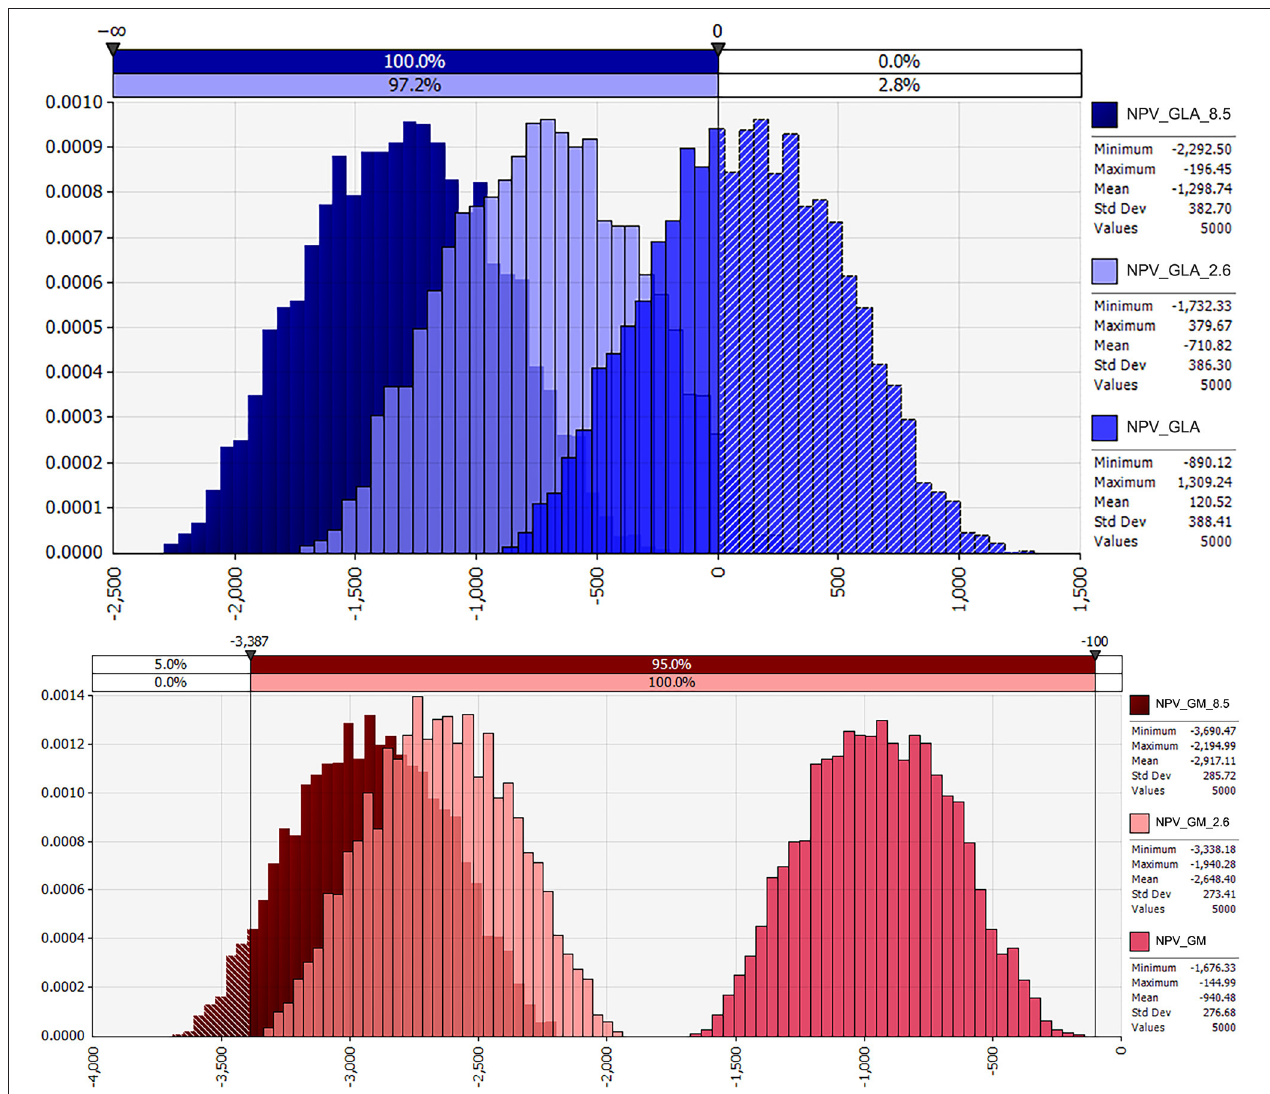
FIGURE 6 | Estimated change in suitable areas for Centauro by 2050 under RCP 2.6 (left) and RCP 8.5 (right)